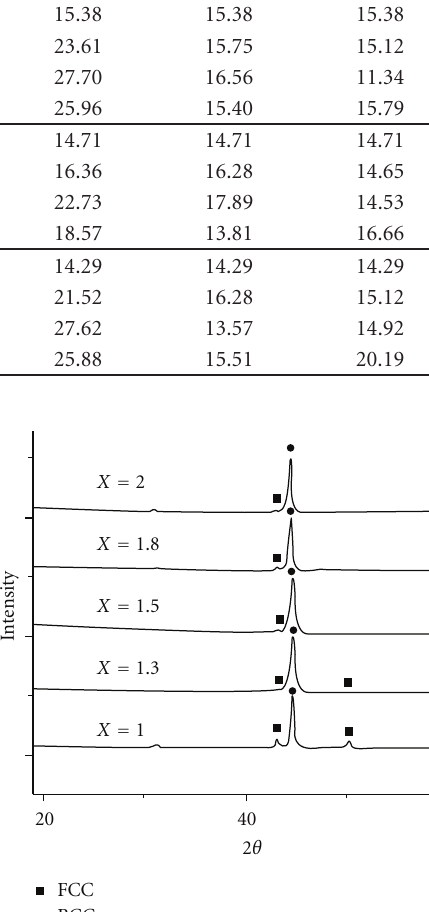
Figure 3: The X-ray Di ff raction patterns.